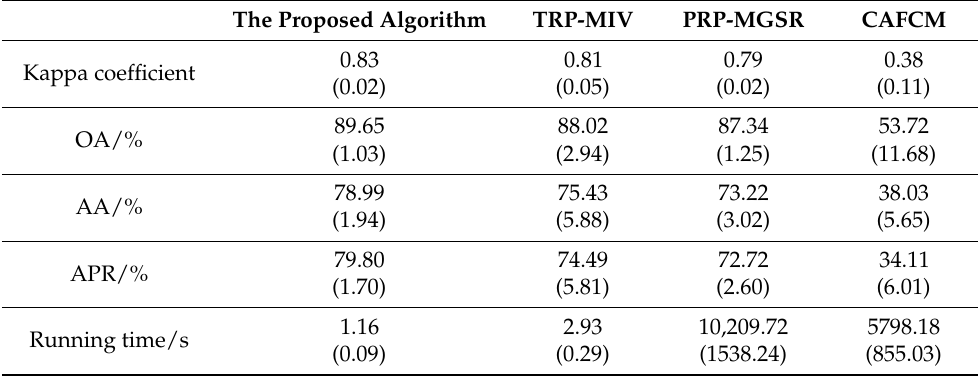
Table 3. Accuracy evaluation of classification results for the Pavia Centre image. (The values in brackets are the variance of 100 trials, and those not in are the mean).